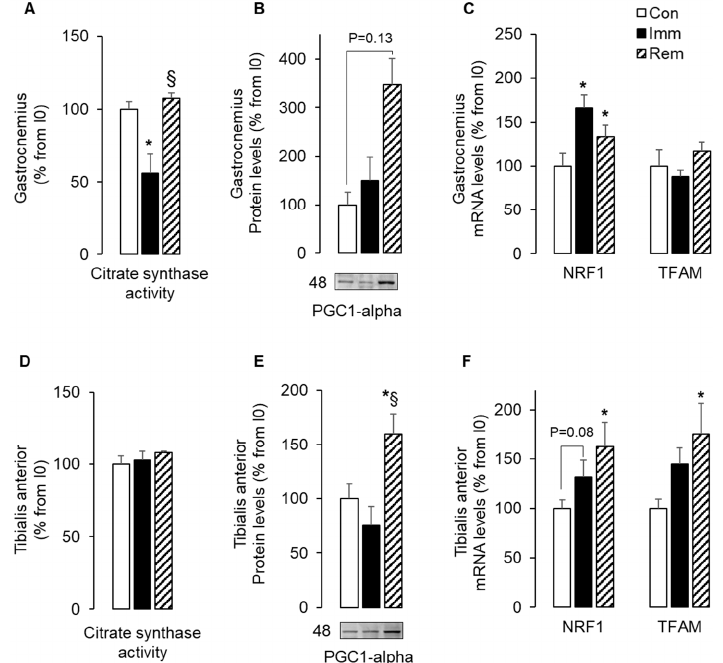
Figure 1. The expression of mitochondria biogenesis markers increased during remobilization. Citrate synthase activity was measured in the gastrocnemius (GA) ( A ) and the tibialis anterior (TA) ( D ), as described in the material and methods section. Protein levels for PGC-1 α were assessed by Western blots in the GA ( B ) and the TA ( E ), quantified and normalized using Ponceau red staining for uneven loading. Representative Western blots are shown below each graph, and molecular weights are given in kDa. mRNA levels for NRF1 and TFAM were measured in the GA ( C ) and the TA ( F ) by RT-qPCR. Data were normalized using 18S rRNA. Protein and mRNA levels were expressed as % from the Con group. Statistical di ff erences were assessed by ANOVA, as described in Materials and Methods. * p < 0.05 vs. Con, § p < 0.05